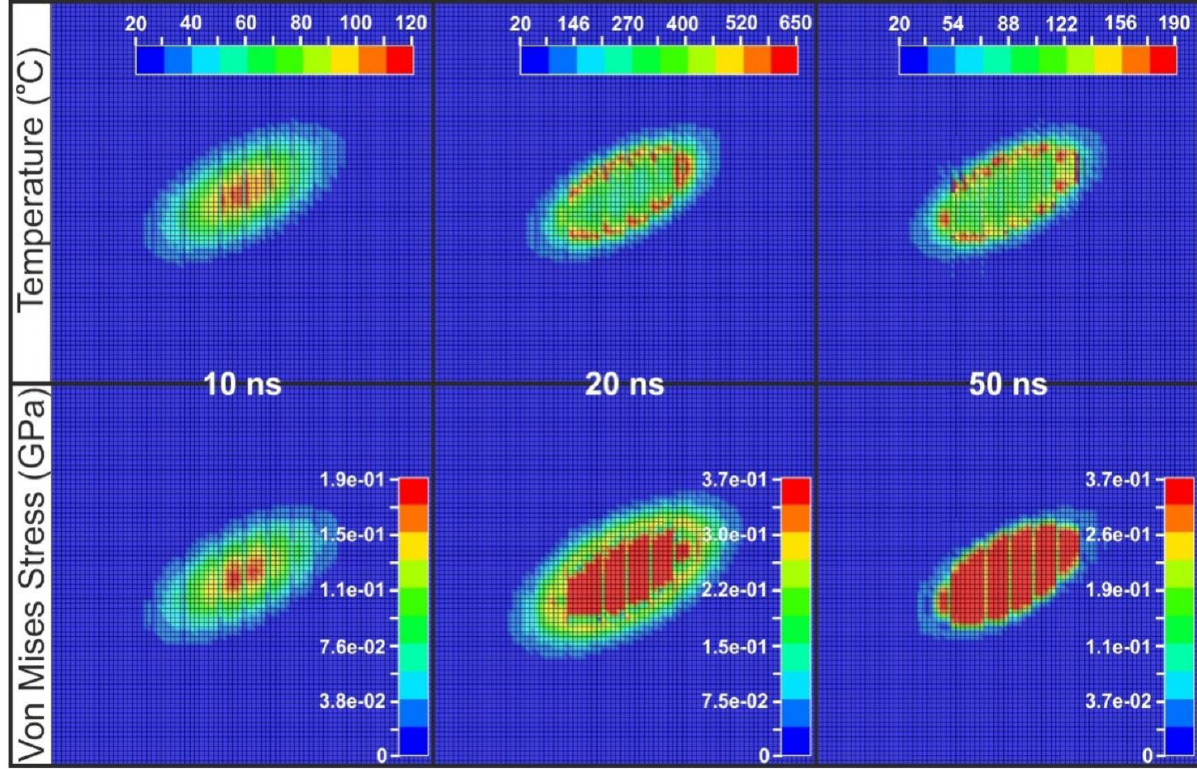
Figure 4. Representative FEM results of temperature and Von Mises stress distribution for the model with 0.5- µ m step accuracy at 10 ns, 20 ns, and 50 ns and for laser fluence of 2 J/cm 2